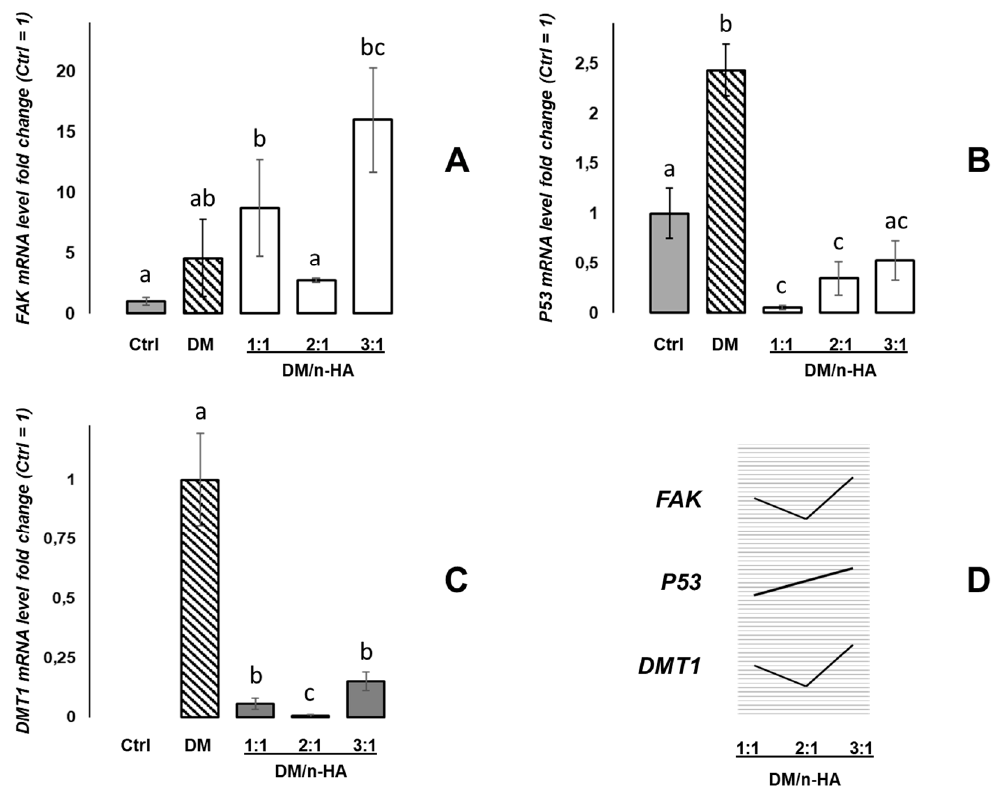
Figure 2. mRNA expression analysis by qPCR in MG63 cells grown in the absence and presence of the 5 µg/mL DM and DM/n-HA (1:1, 2:1, 3:1) for 48 h. The amounts of each target mRNA of the FAK ( A ), P53 ( B ) and DMT1 ( C ) genes were calculated as 2 - Δ Ct values obtained from the real-time PCR assays. C t values of the detected mRNA targets were normalized with respect to the 28S RNA housekeeping gene, and were expressed as fold change ( y -axis) with respect to the control mean values (Ctrl = 1) except for ( C ), where data are expressed as fold change with respect to the DM value (DM = 1). Statistical analysis of variance of the means was assessed by one-way ANOVA and Bonferroni post-hoc test [ n = 4; histograms (mean values) with a common letter are not significantly different with p < 0.05 level of significance; histograms (mean values) not sharing any letter are significantly different with p < 0.01 level of significance]. In ( D ) graphic summary of the three mRNA expression trends reported for the DM/n-HA 1:1, 2:1, 3:1 experimental conditions.